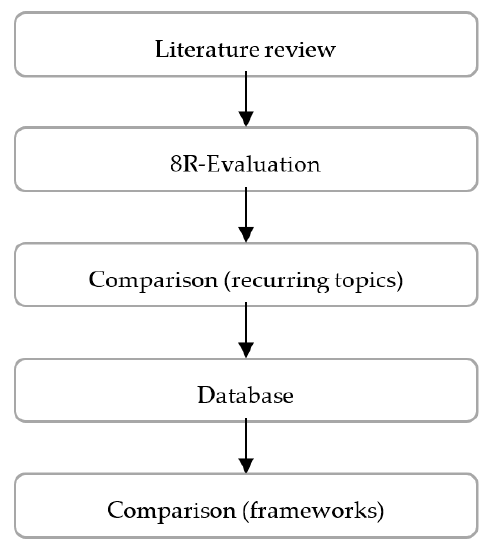
Figure 2 . Data collection and evaluation pathway .